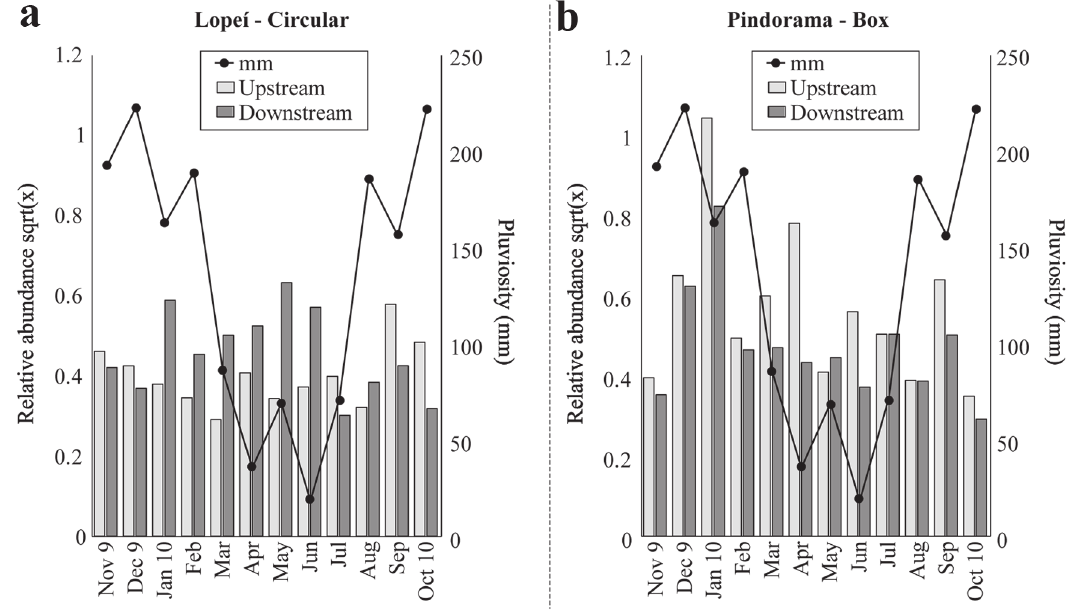
Fig. 10. Temporal pattern of the precipitation and abundance of fish in the sampled stretches of the Lopeí stream - circular culvert ( a ) and Pindorama stream - box culvert ( b ).